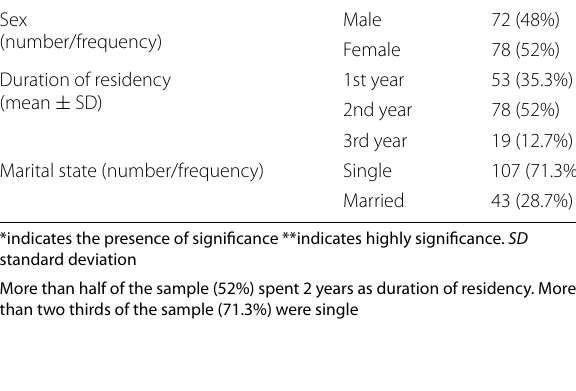
the sample (71.3%, n 107) were single and 28.7% ( n = 43) of them were married (Table 1). The three levels of residency were included, where